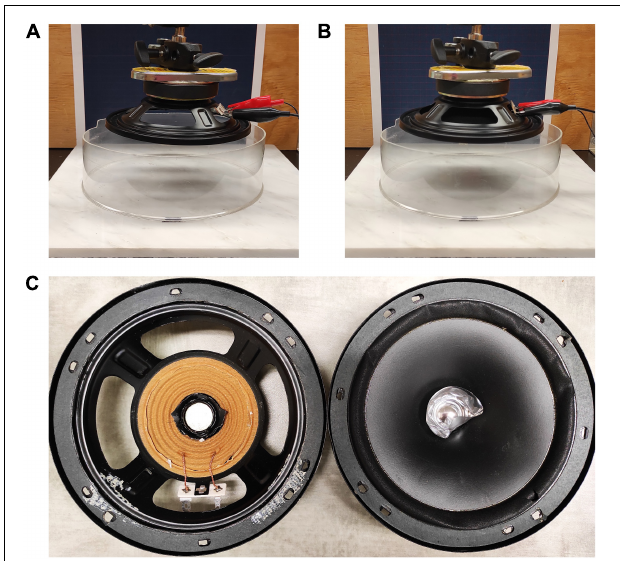
FIGURE 1 | Environmental Treatments—No Noise and Noise Signaling Environments. The mating arenas were set on a granite platform with the speakers held on top of the arena with mechanical arms (A,B) . One of the speakers had the speaker cone removed ( A,C left) and thus did not introduce air particle movement. The other speaker had the speaker cone intact ( B,C right) and introduced air particle movement. All trials were run in the dark.